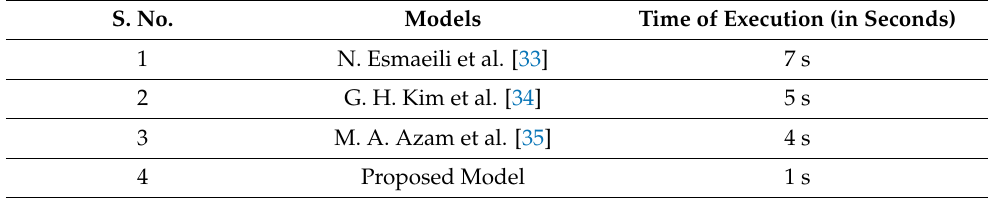
Table 2. Comparative analysis of the proposed model and existing model time of execution. S. No.